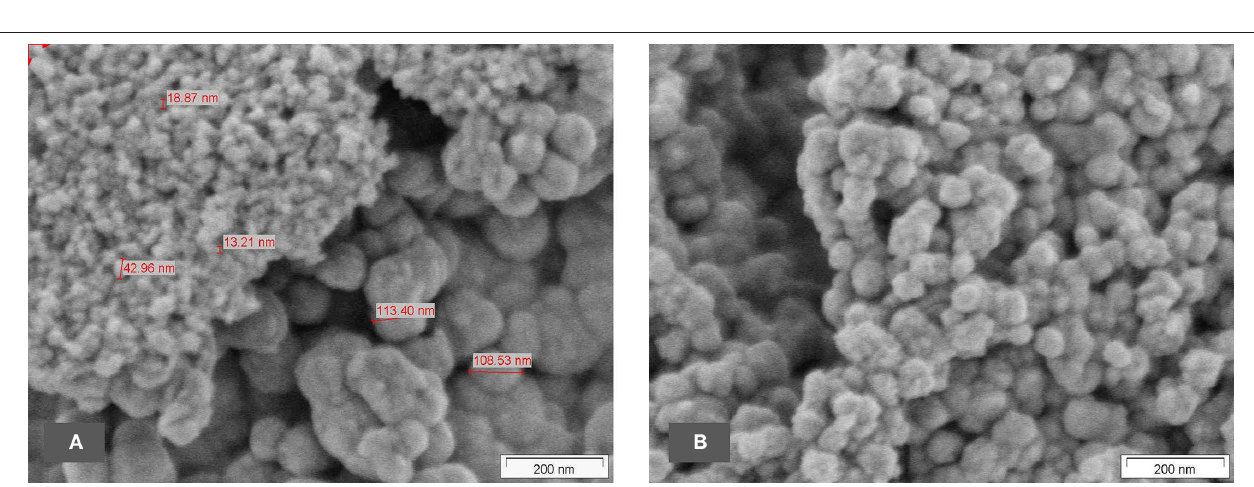
FIGURE 12 | (A,B) SEM micrographs of the final sample of oat